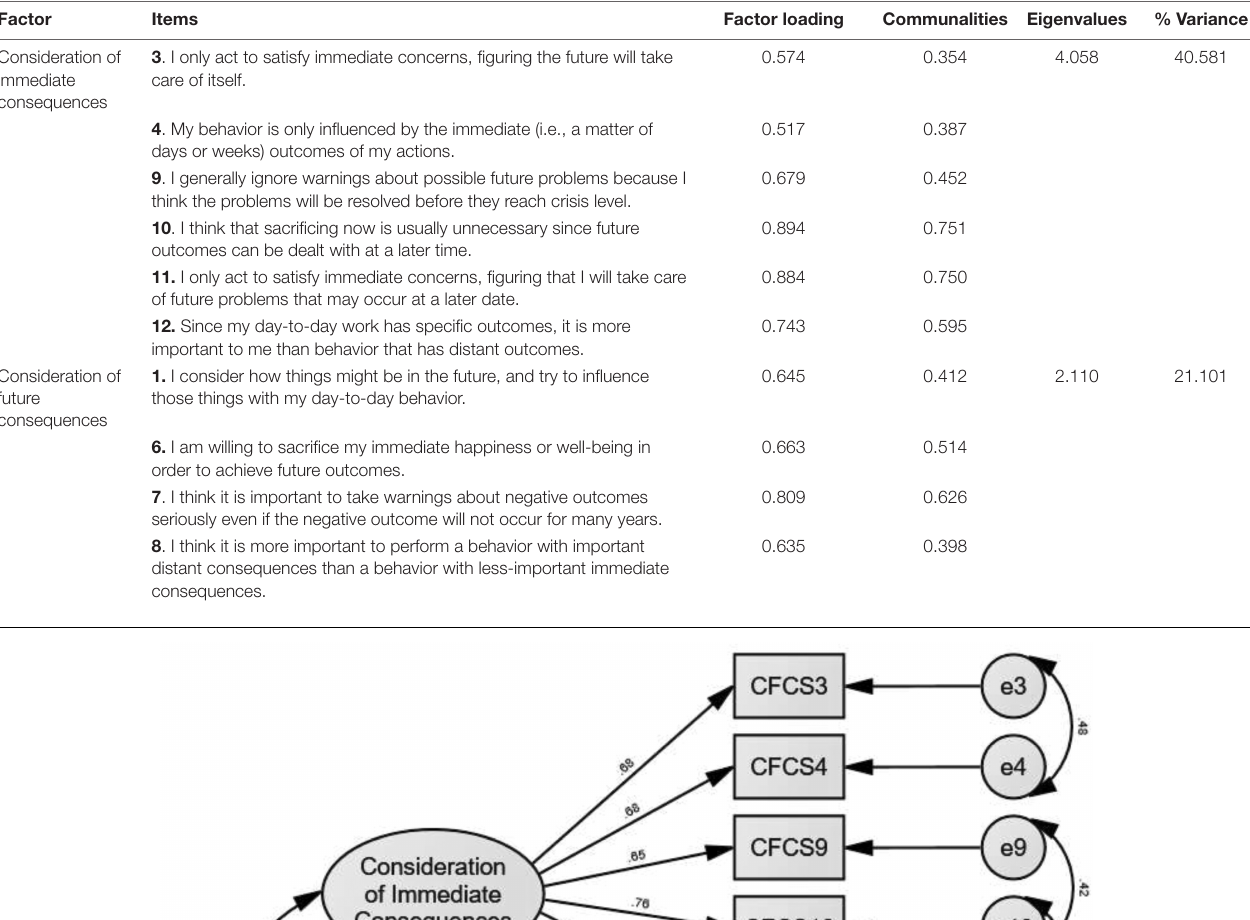
TABLE 2 | The result of EFA on the two-factor Malaysian version of CFC scale. Factor Items Factor loading % Variance